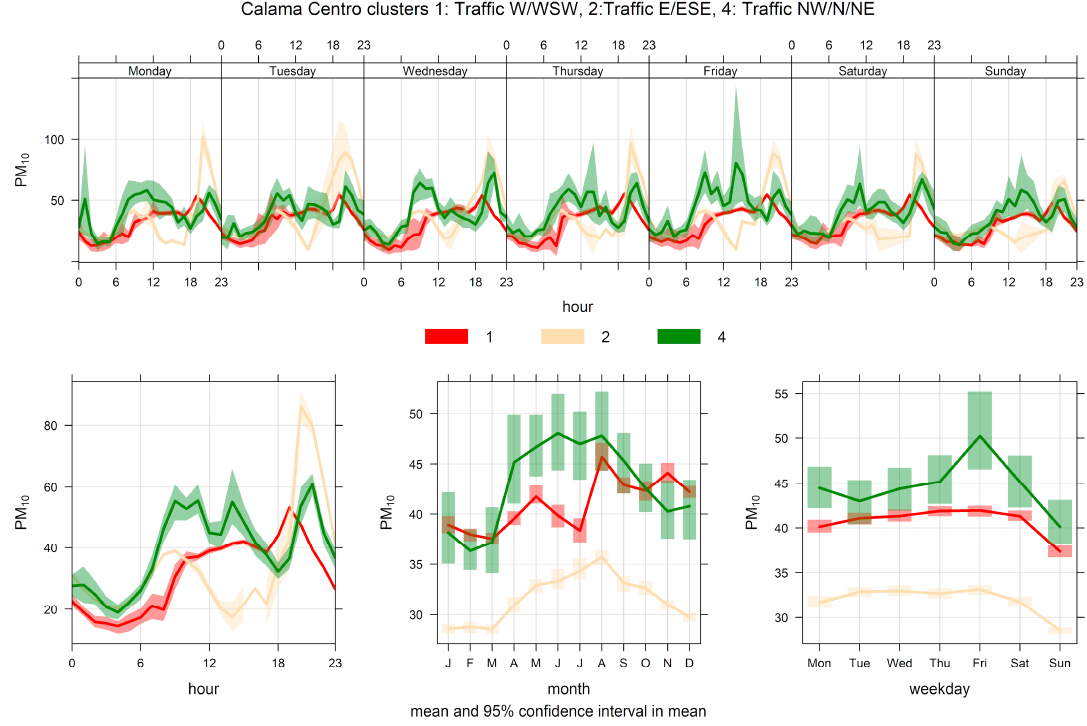
Figure 4. Time variation plot for cluster analysis source apportionment results for ambient PM 10 at Calama, 2012/10–2020/08, for a five-cluster solution. Only clusters 1, 2, and 4 are plotted for clarity’s sake.